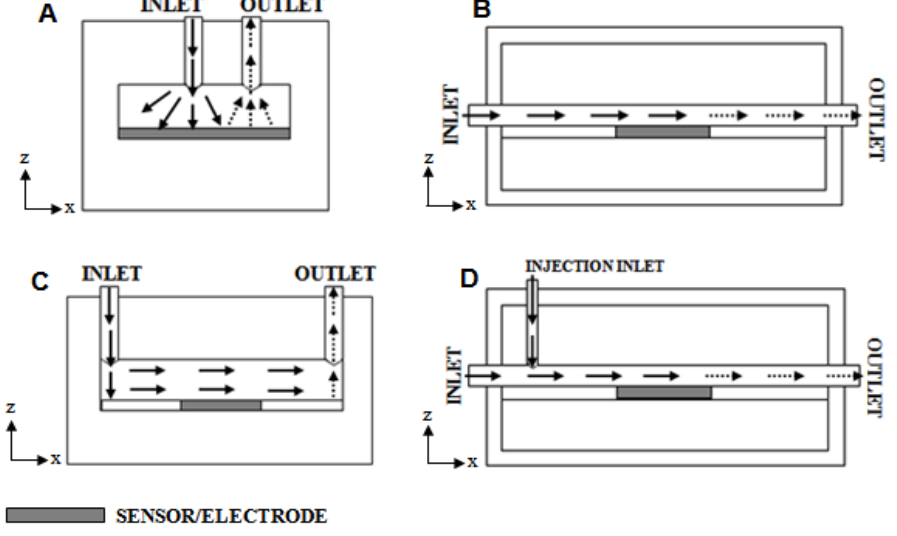
Figure 1. Schematic diagrams of common flow cell design types used with biosensors and other sensor types: ( A ) impinging jet direct onto sensor surface, ( B ) channel flow with embedded sensor, ( C ) impinging jet delivery with channel flow over embedded sensor, ( D ) injection into a flowing carrier channel